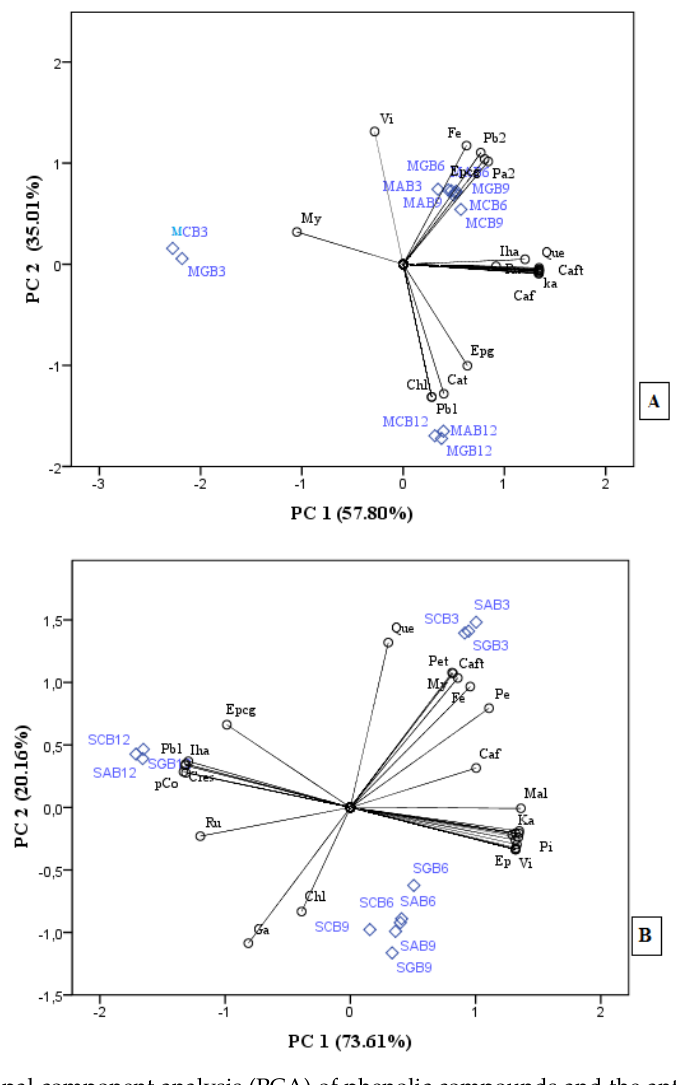
Figure 1. Principal component analysis (PCA) of phenolic compounds and the antioxidant activity results for sparkling Moscatel ( A ) and Syrah ( B ) wines stored in bottles of different colors for 12 months.